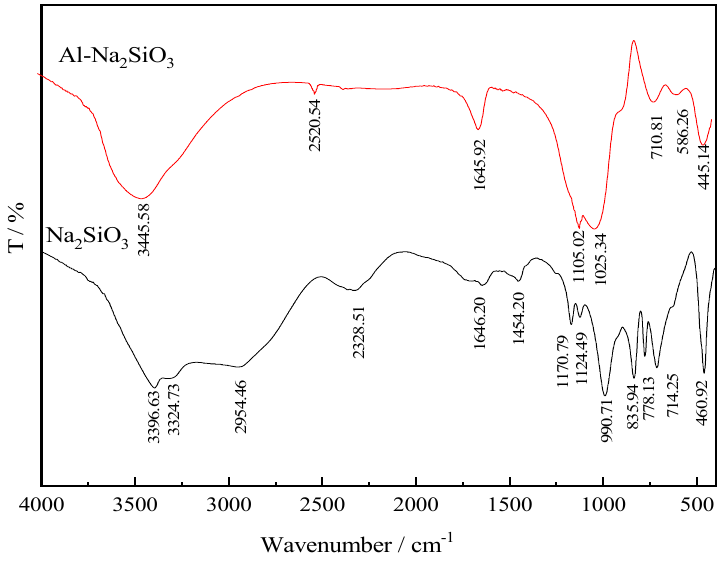
Figure 4. Fourier-Transform Infrared (FTIR) spectra of Na 2 SiO 3 and the Al-Na 2 SiO 3 polymer.